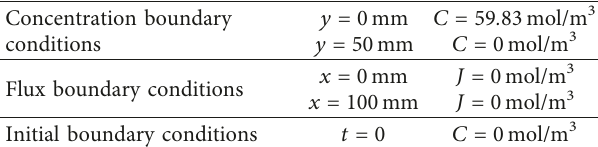
Table 4: Initial and boundary conditions.